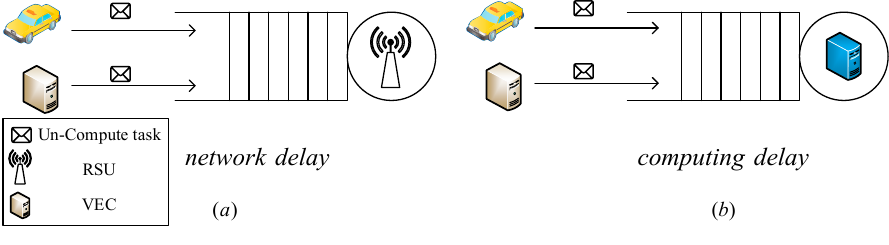
Figure 4. Vehicular task queuing model .